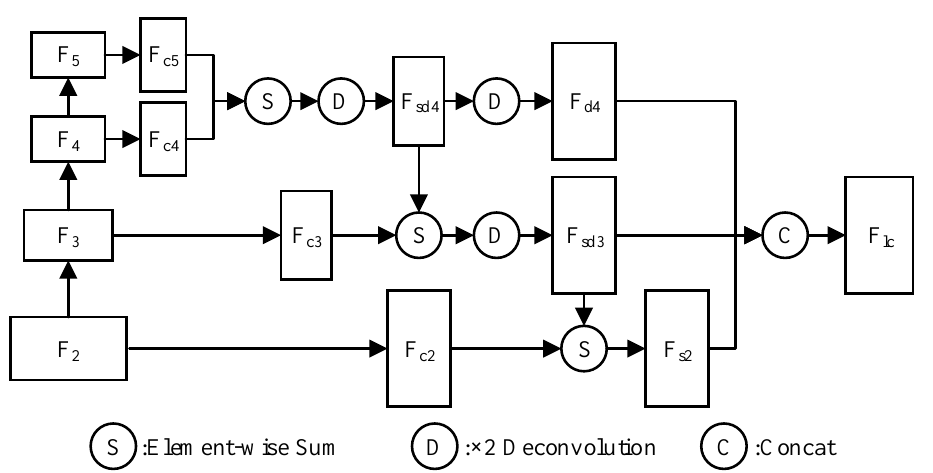
Figure 2. Cascaded Cross-layer Fusion Module